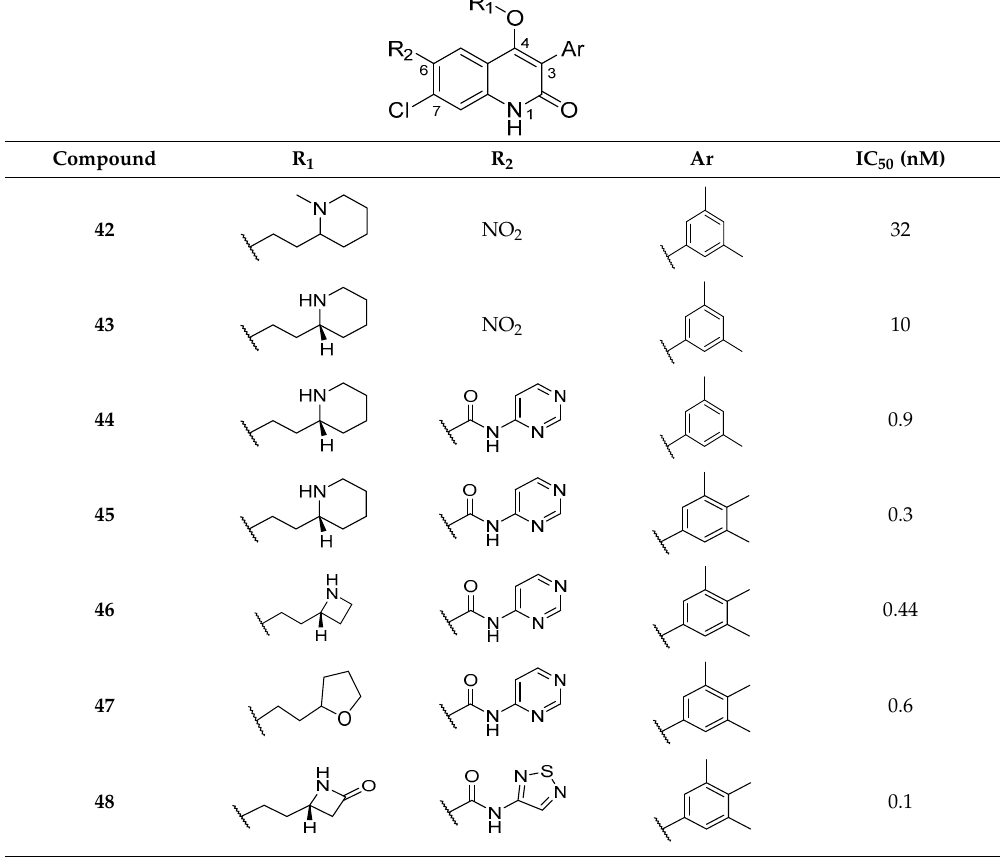
Table 8. Quinolone derivatives and their binding affinity at human GnRH-R.